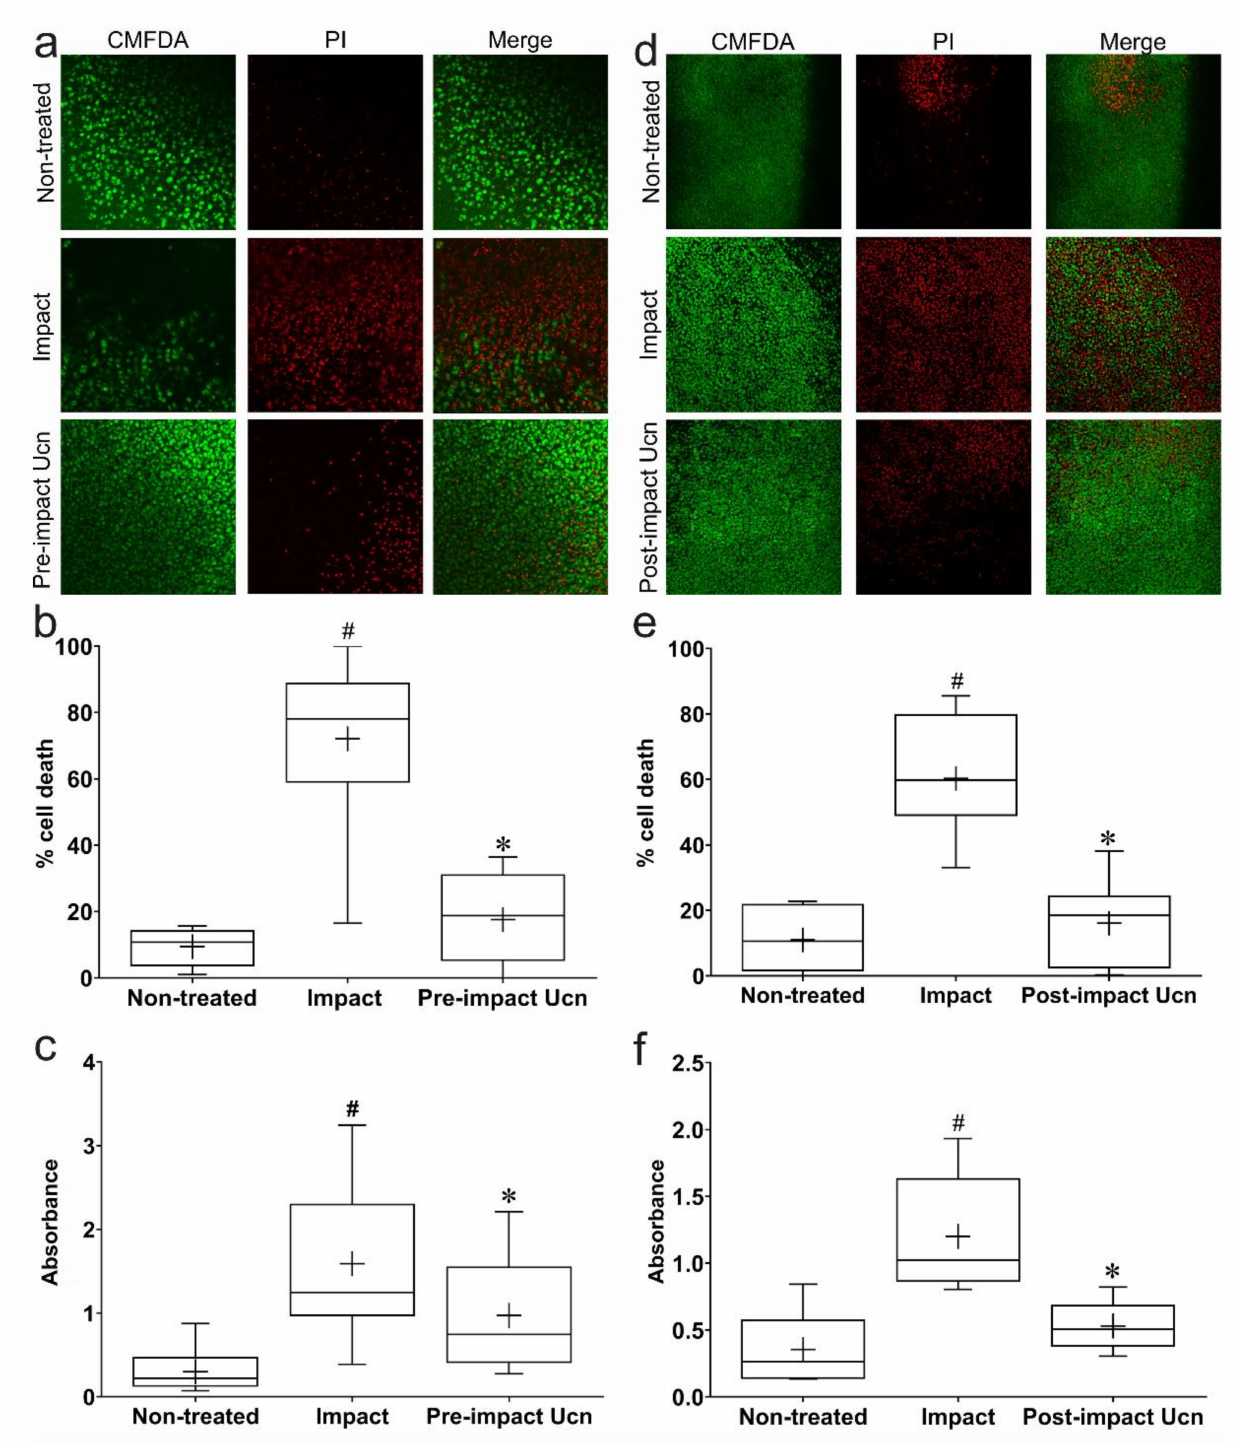
Figure 2. Pre-treatment and post-treatment of porcine articular cartilage with Ucn reduces trauma- induced cell death. Representative confocal images of porcine articular cartilage explants 72 h post- impact with or without Ucn pre-treatment ( a ) or post-treatment ( d ). Viable cells shown in green (CMFDA) and dead cells in red (PI). Quantification of percentage cell death 72 h post-impact with or without Ucn pre-treatment ( b ) or post-treatment ( e ) ( n = 6 explants, 5 fields of view/explant; # = p < 0.01 vs. non-treated, * = p < 0.01 vs. impact). LDH absorbance readings from media collected at 72 h post-impact with or without Ucn pre-treatment ( c ) or post-treatment ( f ) ( n = 6 explants; # = p < 0.01 vs. non-treated, * = p < 0.01 vs.